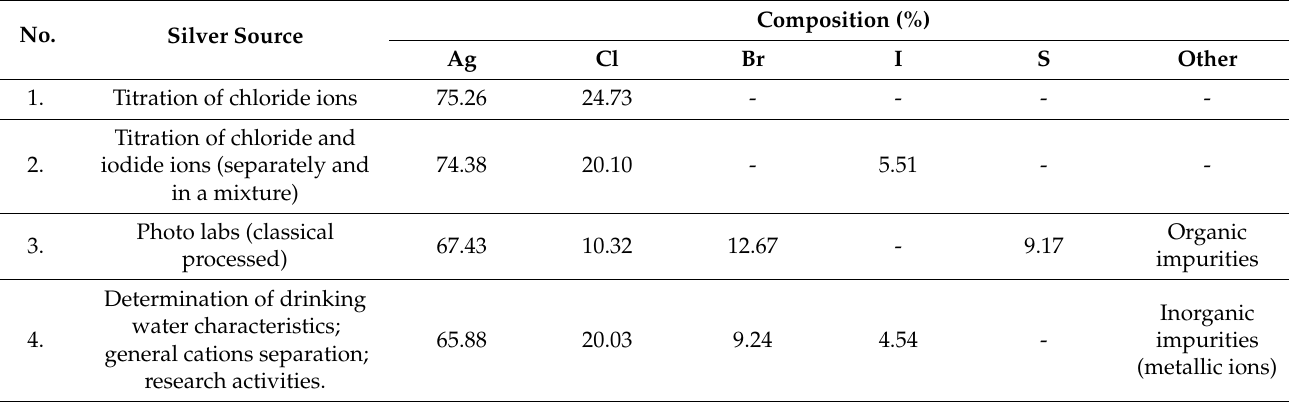
Table 3. Composition of silver raw materials depending on their